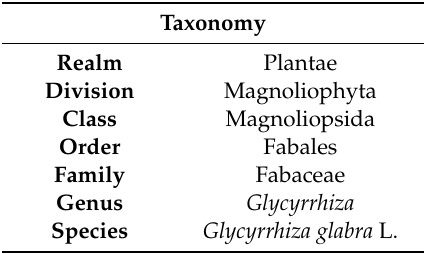
Table 1. Scientific classification of G. glabra